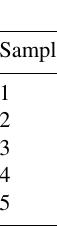
Figure 4. (a) Some rare framboids yield such organization depicted here, with a thin pyrite shell with (sub-)euhedral morphology, host- ing fillings made up of pyrite. (b) Close-up view of (a) . Table 1. Carbon content of the five